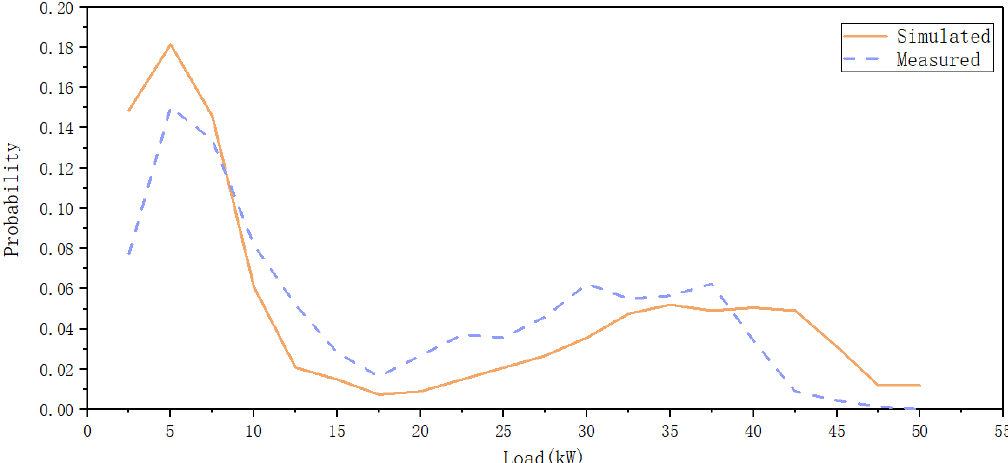
Figure 12. Comparison result of the load probability density of the hourly simulated value and the measured value of the office building every day of the week.